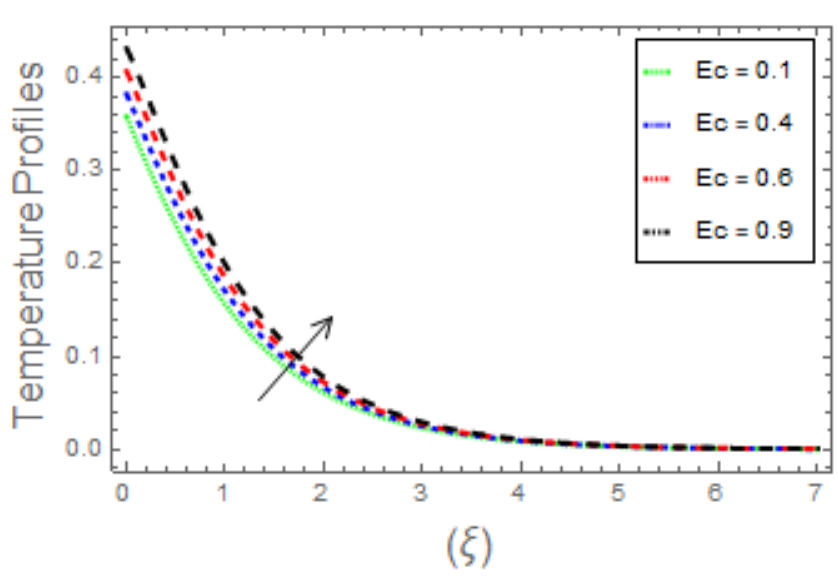
Figure 17. Variation in T due to Ec . Figure 19 elucidates the E 1 effect on fluid C ( ξ ) profiles. As estimated, the C ( ξ ) augments through larger activation energy parameter E 1